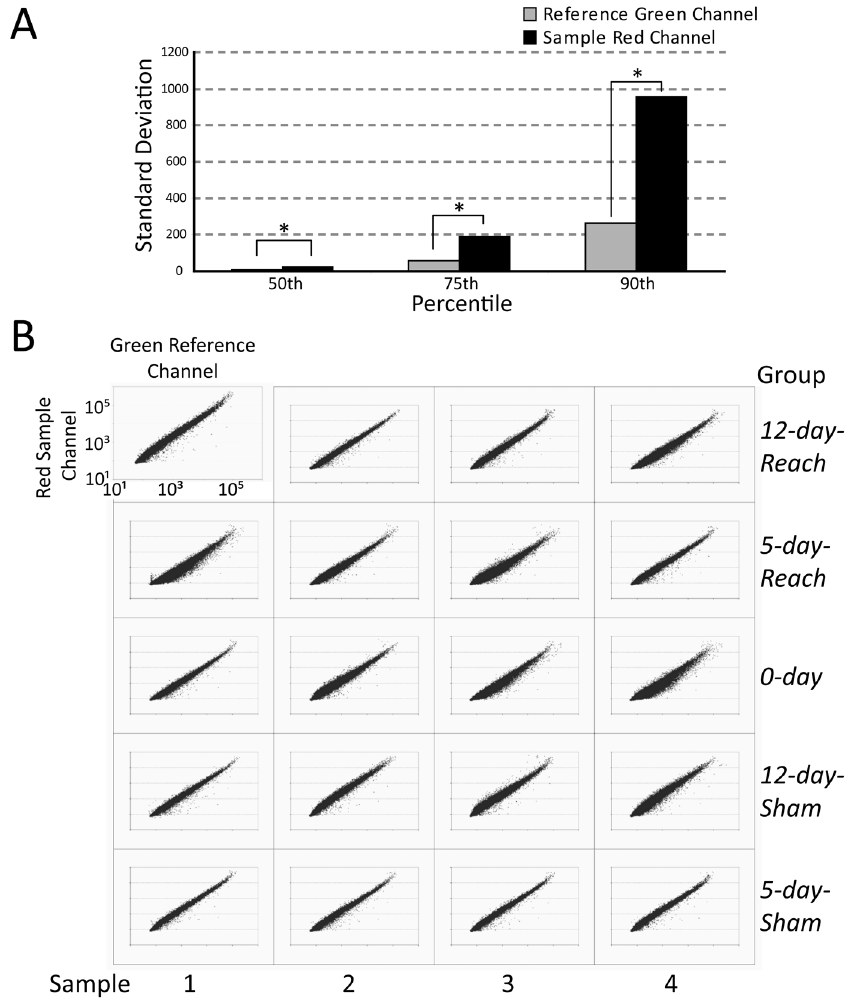
Figure 5. Microarrays had consistent data quality across groups. A, We verified that in our 2-color hybridizations, most of the inter-group variation in gene expression was due to variability of the sample channel (red) but not the reference channel (green). We computed the standard deviation, across the 20 arrays, of the raw signal intensity of the sample red channel (black) and the reference green channel (light grey), respectively, at three percentiles of the signal distribution. For all tested percentiles, the standard deviation from the sample channel was clearly much higher than that from the reference channel (F-test on variances, p , 0.01). B, We further validated that the hybridization quality of the 20 arrays was consistent across experimental groups. We show here a scatter plot of the raw signal intensity (log scale) of the red sample channel against that of the green reference channel for each microarray (N=41,012). As can be seen, the overall ratio of signal intensities between the two channels was very reproducible across arrays, with the slope of the linear regression on these data not significantly different across the five groups (p . 0.05, ANOVA). Thus, any differential gene expression we identified is unlikely to be just due to fluctuation of signal intensity in one of the two channels as a result of inconsistent hybridization quality across arrays. Note that the scatter plot of the upper-left panel is enlarged relative to the others for the graphical purpose of clearly depicting the axis labels.